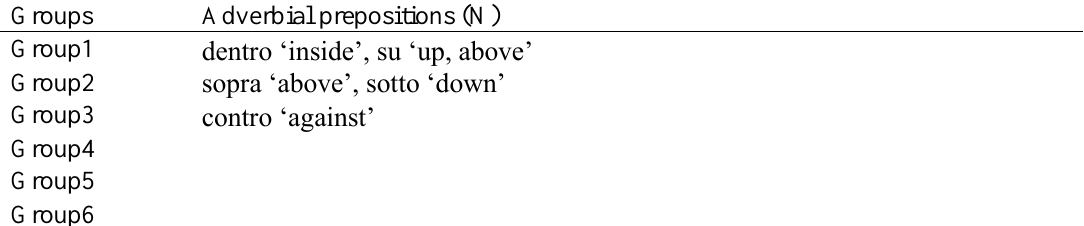
Table 5 . First appearance of prepositional adverbial items across MLU groups Groups